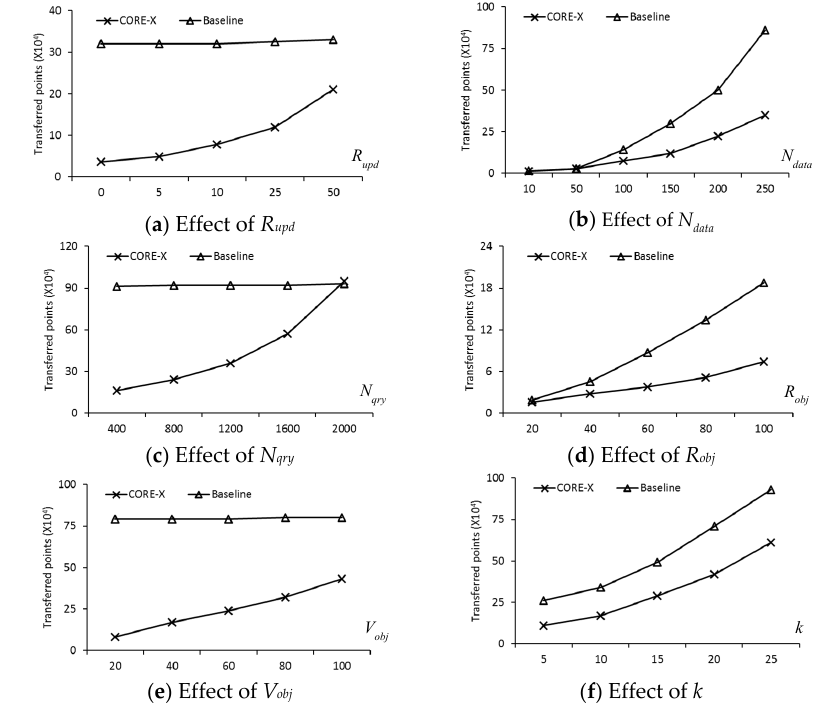
Figure 17. Comparison of the communication cost. ( a ) Effect of R upd ; ( b ) Effect of N data ; ( c ) Effect of N qry ; ( d ) Effect of R obj ; ( e ) Effect of V obj j ; ( f ) Effect of k.